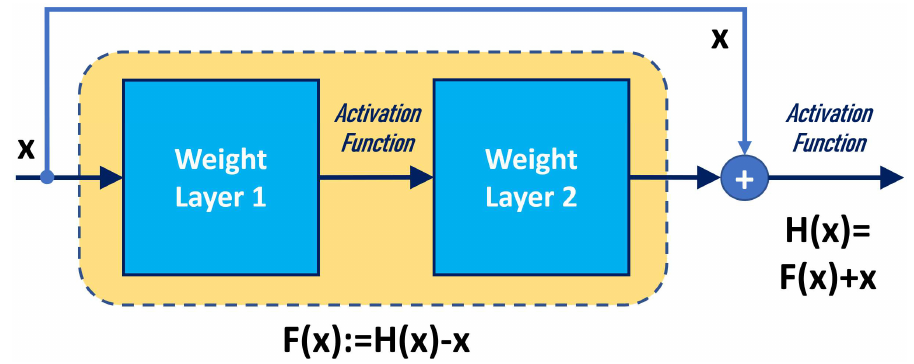
Figure 4. A residual block. There is a shortcut between the input x and the desired output H(x). If the output of the nonlinear stacked layers is defined as F(x): = H(x) − x, then H(x) = F(x) + x. This network design enables a skip connection, which allows gradient information to pass through the layers and can avoid the vanishing gradient